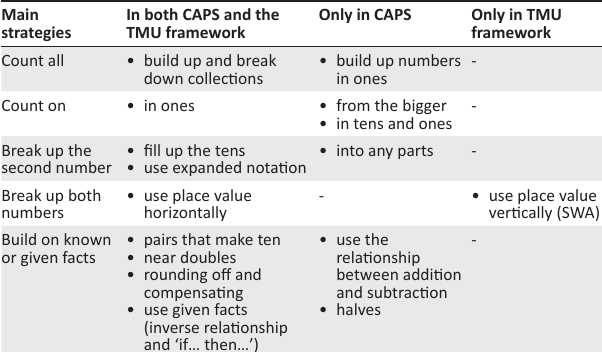
TABLE 3: Appearance of Foundation Phase strategies in CAPS and TMU framework. Main strategies